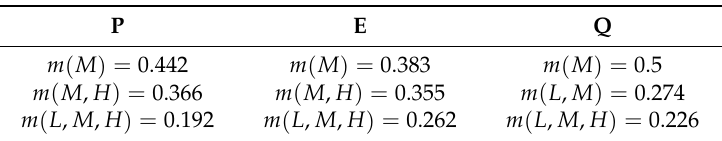
Table 3. BPAs of health state